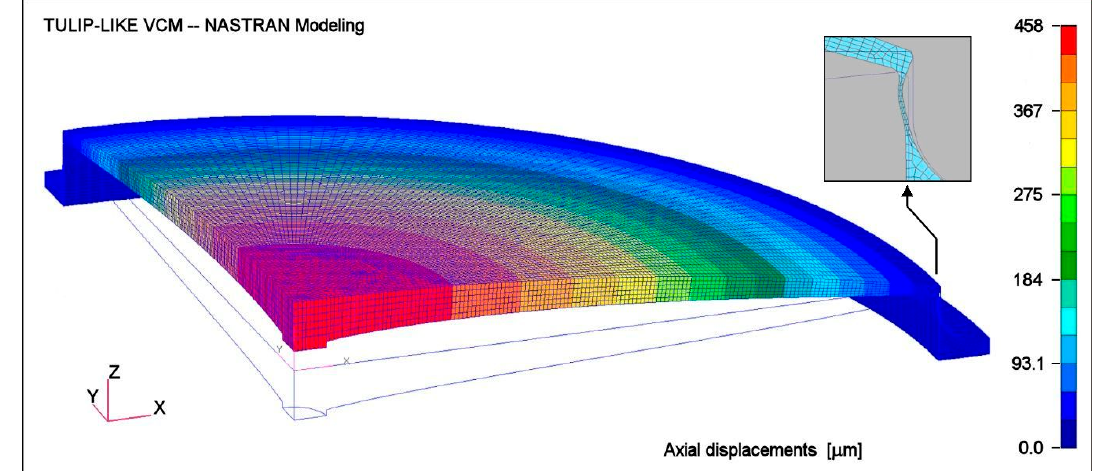
Figure 7. Axial displacements for maximum force F = 14 daN. Mesh model plate ‐ collarette ‐ ring. T = t / t 0 = ( − ln ρ 2 ) 1 / 3 for 0.05 < ρ < 0.9 and t 0 = 300 μ m. A conical shape is designed for 0.9 < ρ < 1 with t ( ρ = 1) = 120 μ m. Collarette thickness 20 μ m.